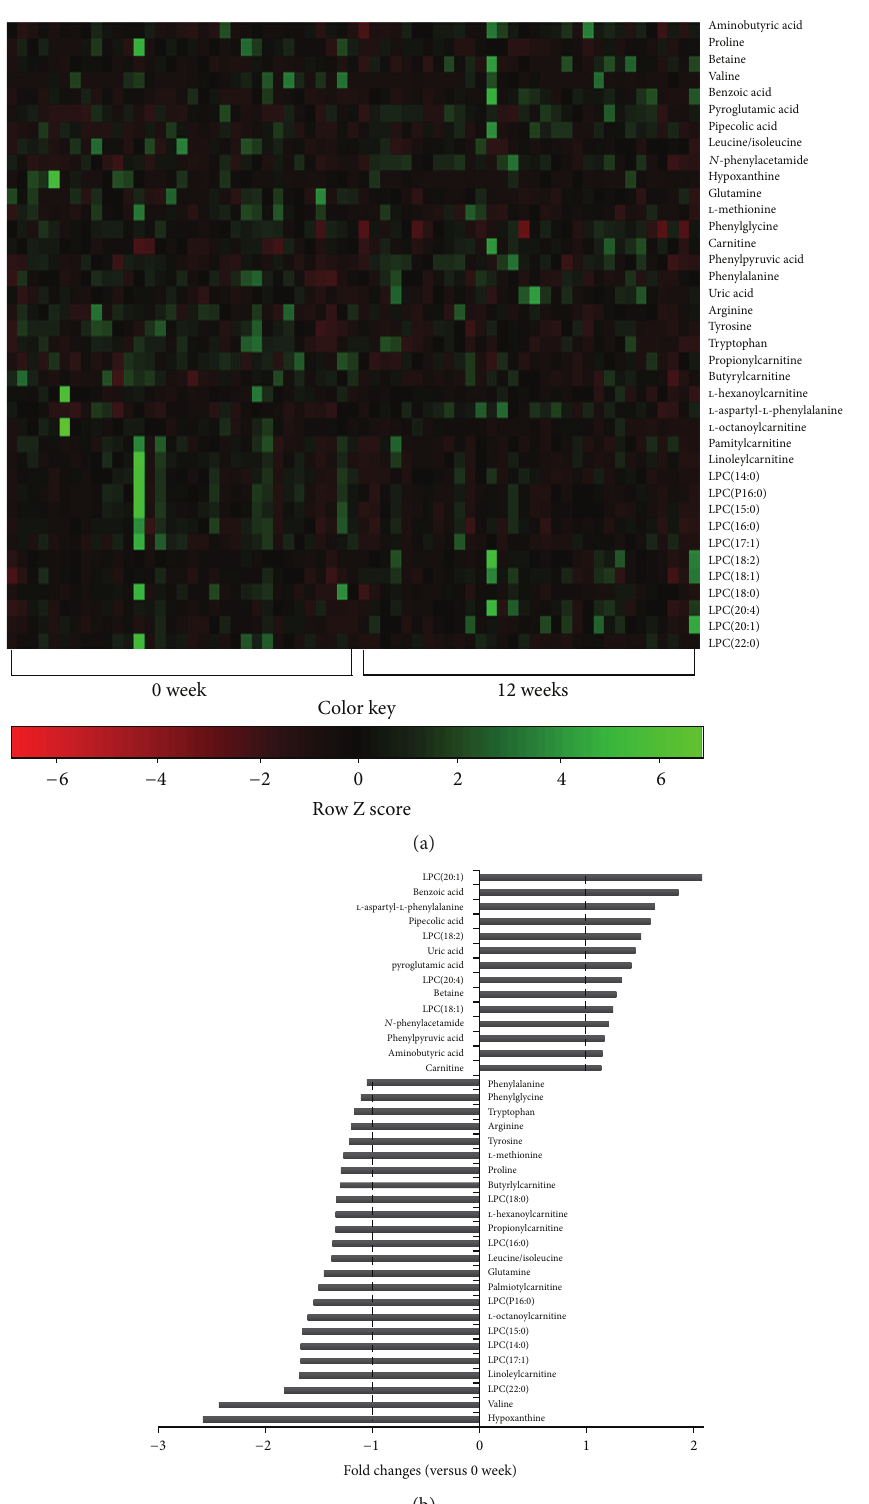
Figure 3: Heat map of the identified serum metabolites from the human subjects showing significant differences among samples (a) and their fold changes at weeks 0 and 12 of intervention (b). The heat map was drawn by 𝑅 with g plots. The fold changes of serum metabolites in subjects at 12 weeks were calculated against those at 0 week and are presented as positive and negative